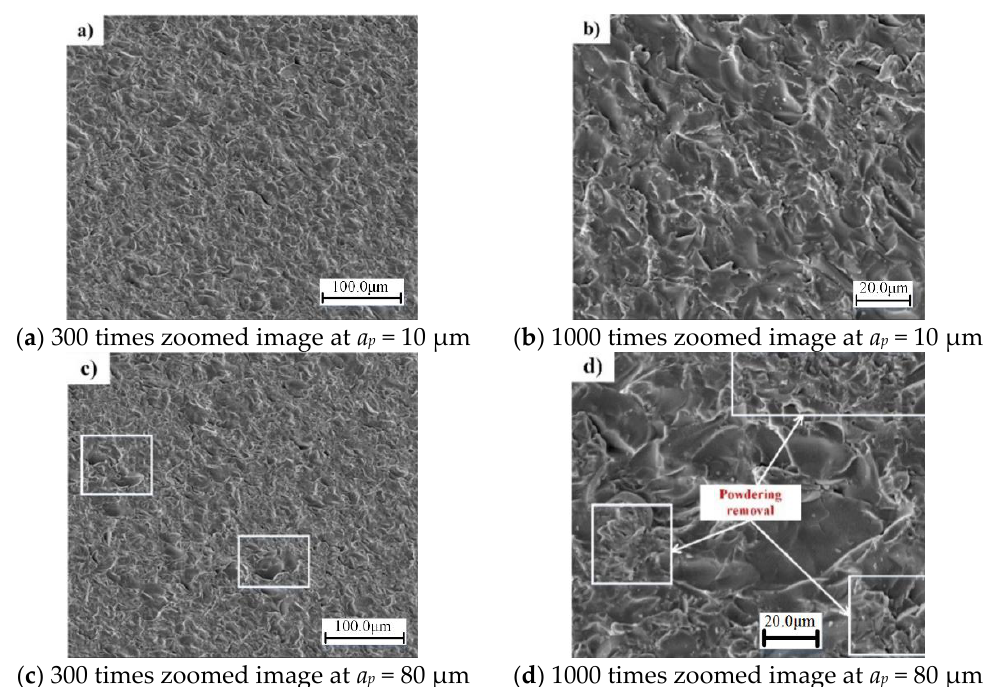
Figure 6. Machined surface morphologies of optical glass material at different grinding depth.